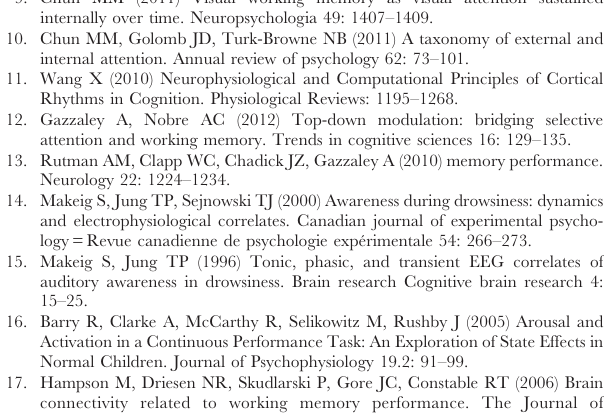
Figure 6. SVD combined regions and association with working memory performance. A: Representative diagram of the delta/theta and beta regions used in the SVD (delta/theta right posterior frontal, delta/theta right parietal, beta right posterior frontal regions). B: The singular values for the SVD matrix indicated that 59% of the variability in the data was present in the first mode, and that this mode correlated with WM performance. The second and third modes contained 35% and 6% of the variability respectively, but these modes did not correlate with performance. C: Displays individual Pearson’s correlation values (r) and significance values (p) for selected region comparisons as well as the calculated dominant (first) mode SVD r and p values. D: Scatter plot showing a strong association between the SVD values of the first mode and three-back d 9 scores.